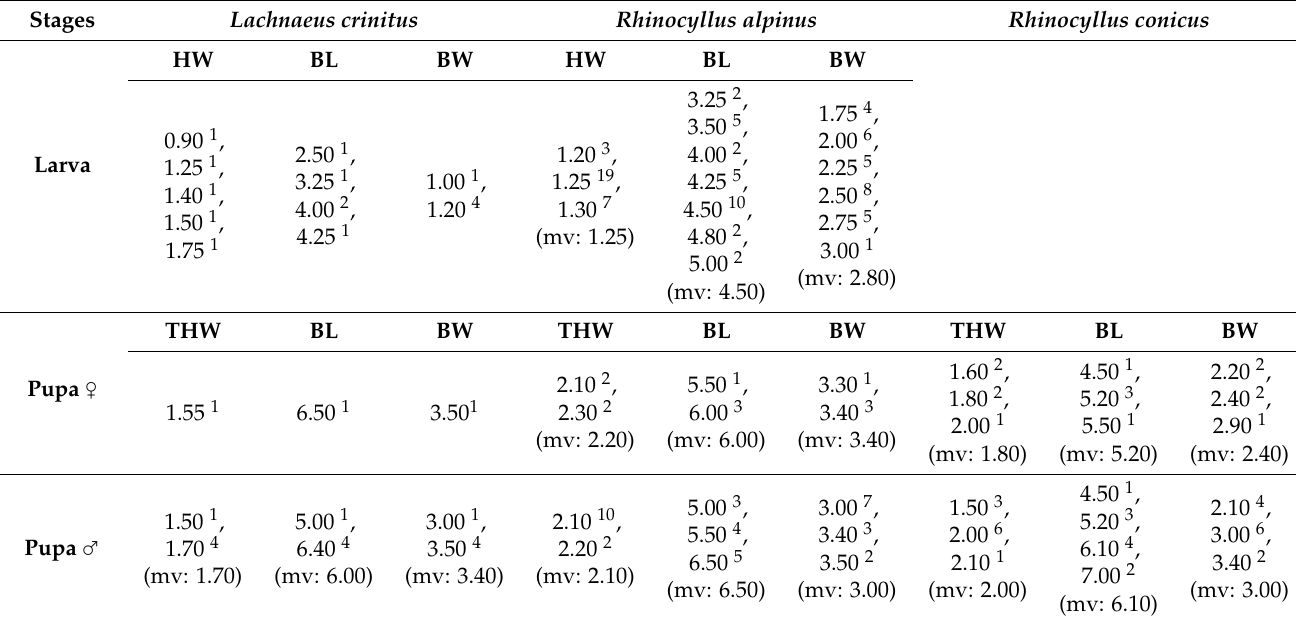
Table 1. Results of measurements of larvae and pupae of Lachnaeus and Rhinocyllus . All data in (mm), n : number of exemplars, mv = medium value. Lachnaeus crinitus Rhinocyllus alpinus Rhinocyllus